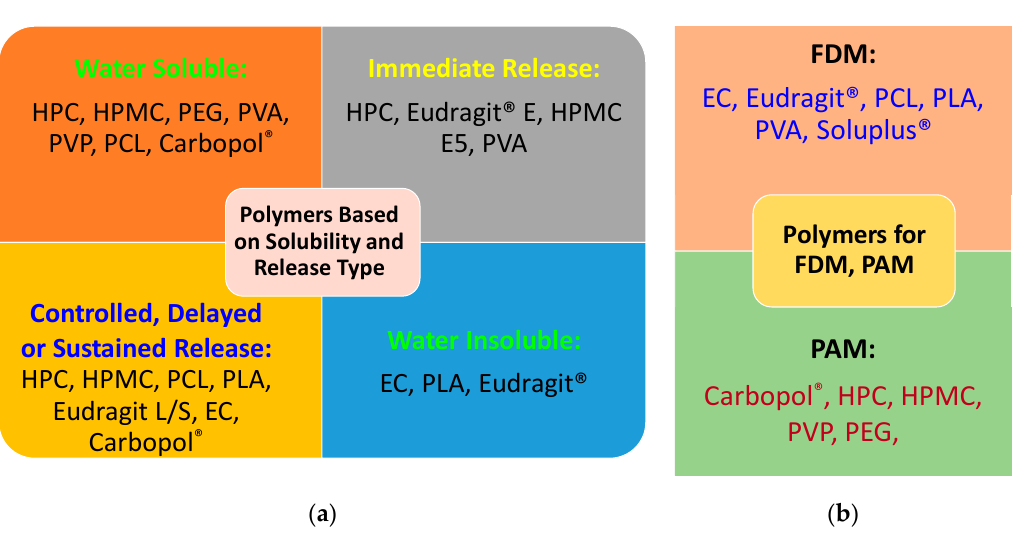
Figure 5. Summary of polymers based on ( a ) water solubility and drug release type, ( b ) their selection for either FDM or PAM 3D printing method.